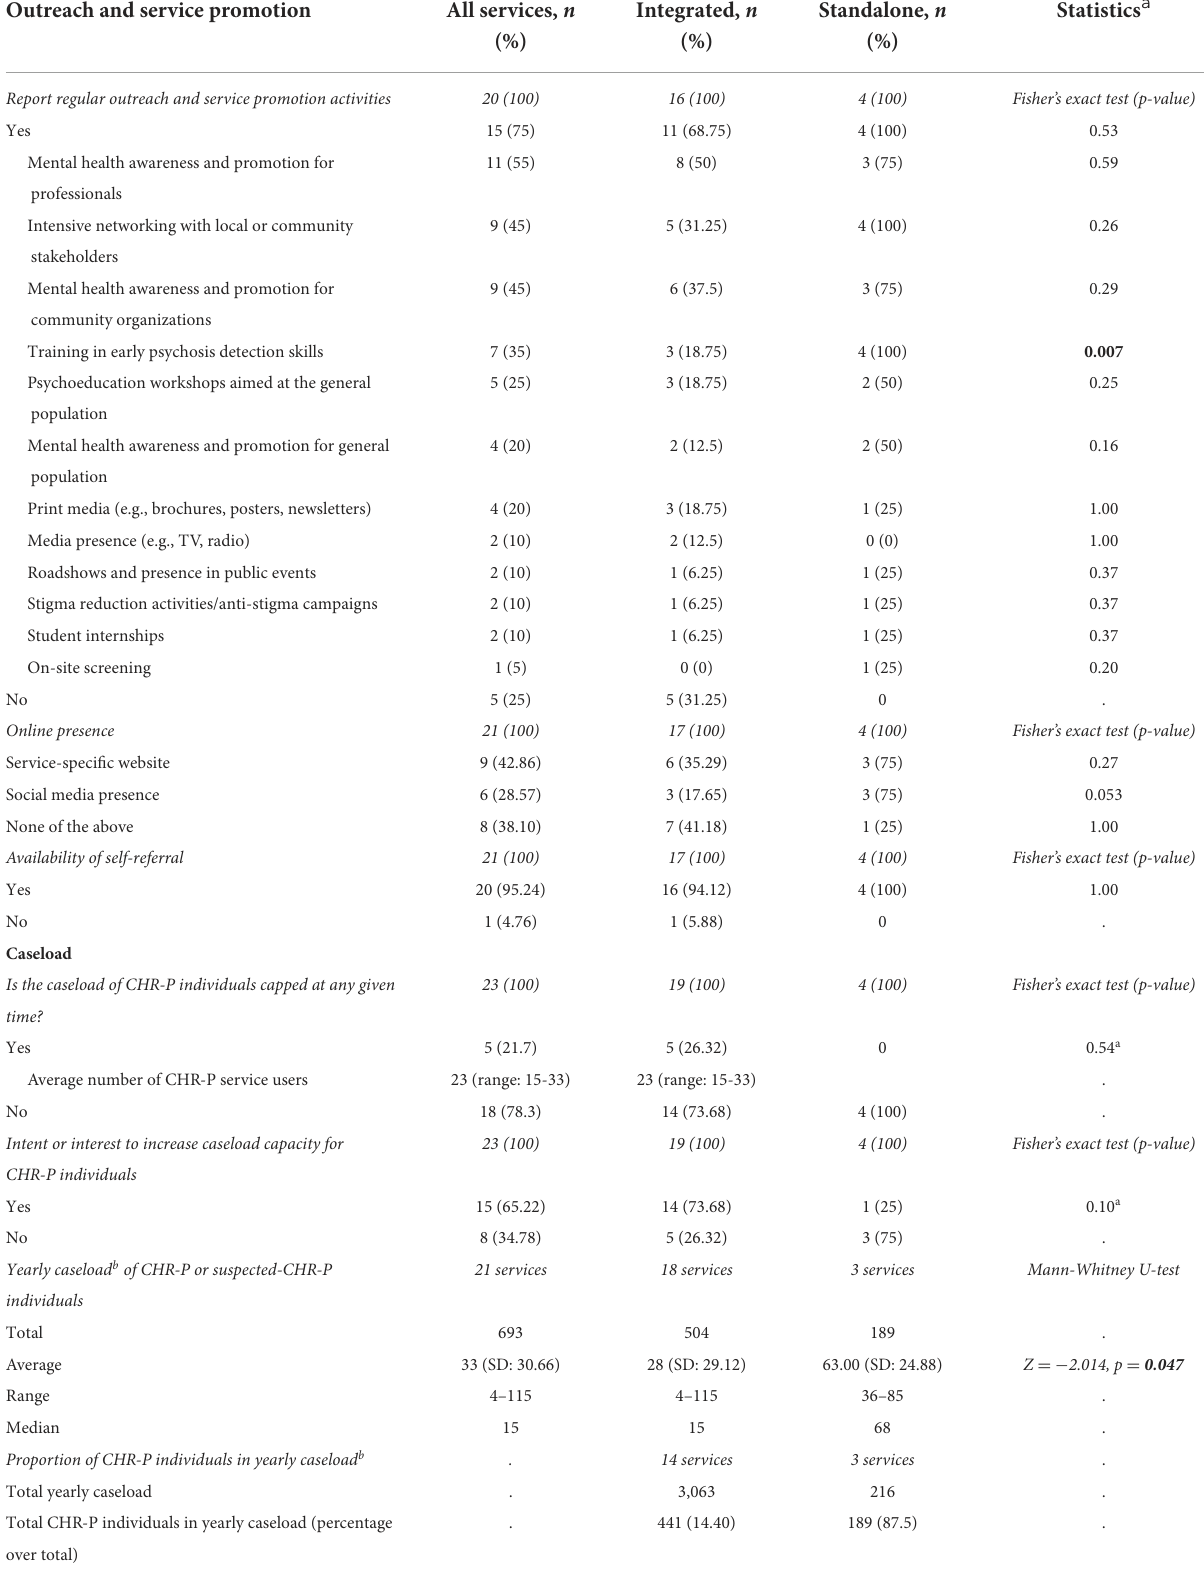
TABLE 2 Detection of at-risk